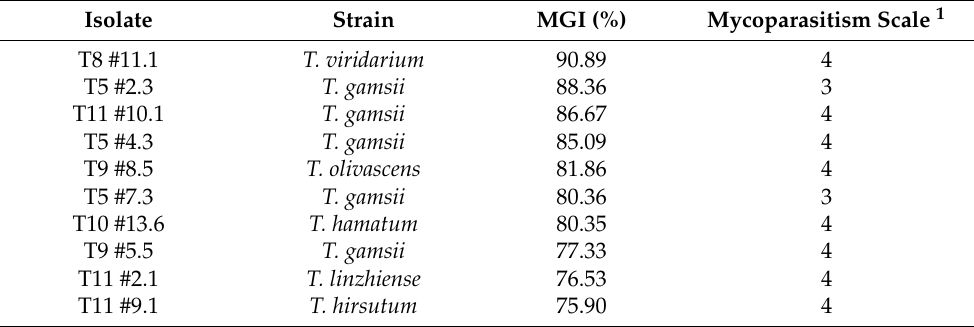
Table 4. Percentage of inhibition and mycoparasitism scale of the selected Trichoderma strains against the native P. cinnamomi . 1 Mycoparasitism scale: colonisation scale of the antagonist on the pathogen colony